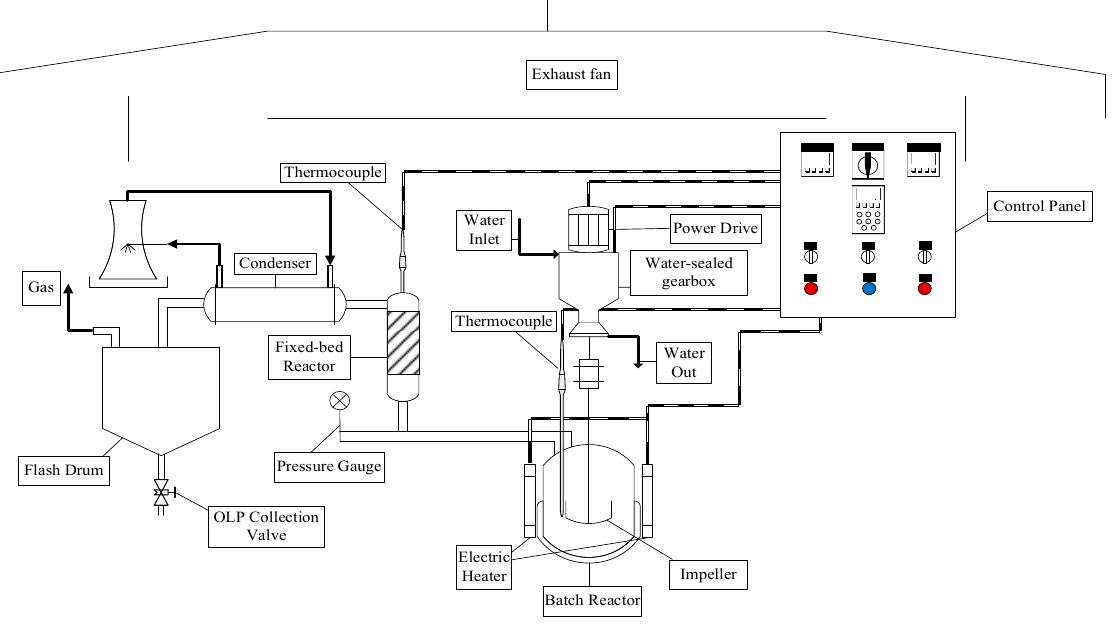
Figure 4. Schematic diagram of bench-scale stainless steel catalytic cracking reactor with a pyroly- sis/batch reactor and a fixed bed reactor.